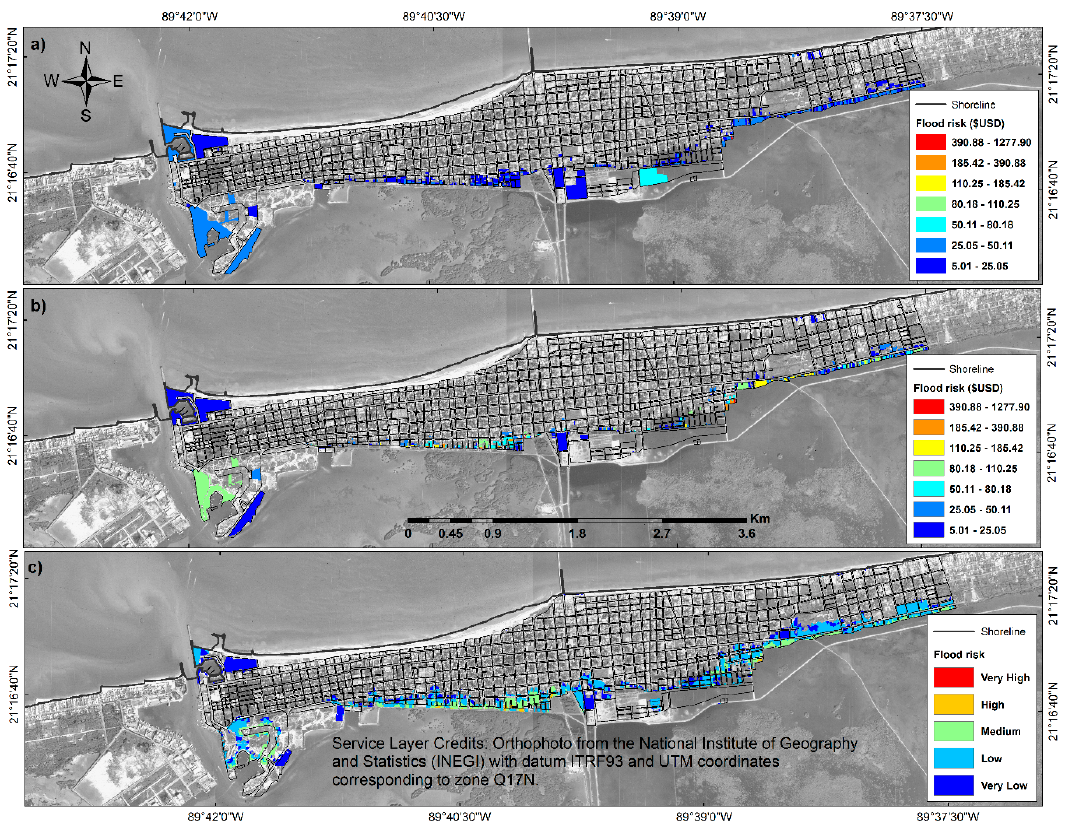
Figure 5. Flood risk of the Norte for Progreso, Yucatan, using ( a ) CENAPRED, ( b ) CENAPREDv2, and ( c ) FRI methodologies. The categories in FRI are also used in FDI_FD (see Table 2 and Figure 6) for